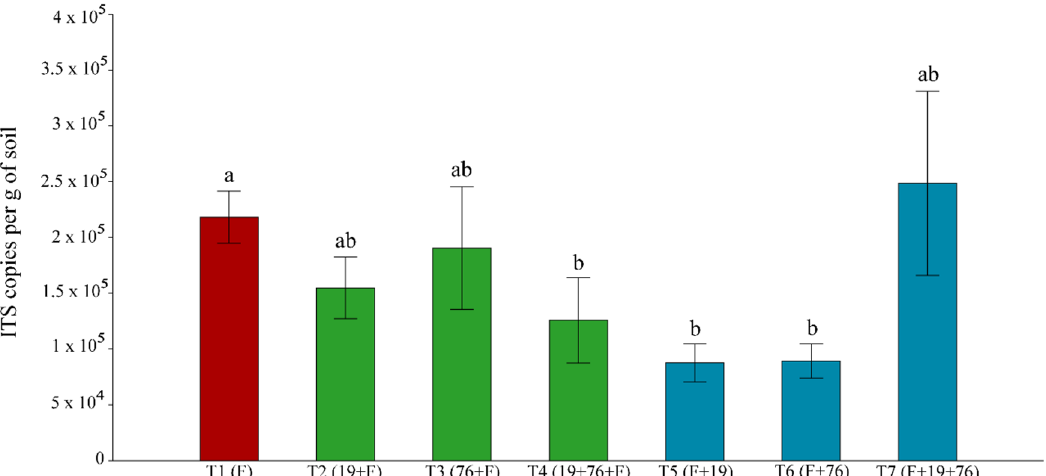
Figure 2. Total fungal population quantified by quantitative polymerase chain reaction (qPCR). The bar values indicate the average of the four replicates (n) of each treatment. T represents each of the treatments from 1 to 7, F represents the inoculum with the fungus P. destruens , 19 represents the inoculum with the bacterium B. velezensis T149-19 and 76 represents the inoculum with the bacterium B. safensis T052-76. The position of letter F (before or after the numbers) indicates the moment of inoculation of the fungus (before or after bacteria). Treatments that do not share a letter have a mean difference that is statistically significant based on Tukey’s HSD test ( p < 0.05).